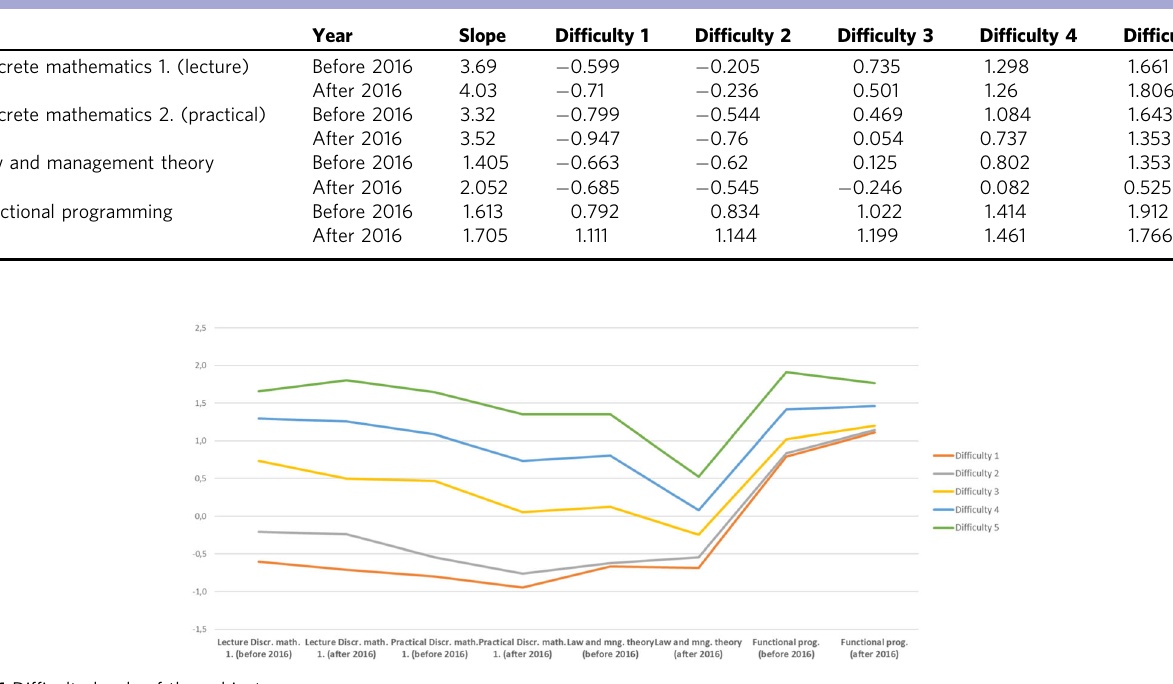
Fig. 1 Dif fi culty levels of the